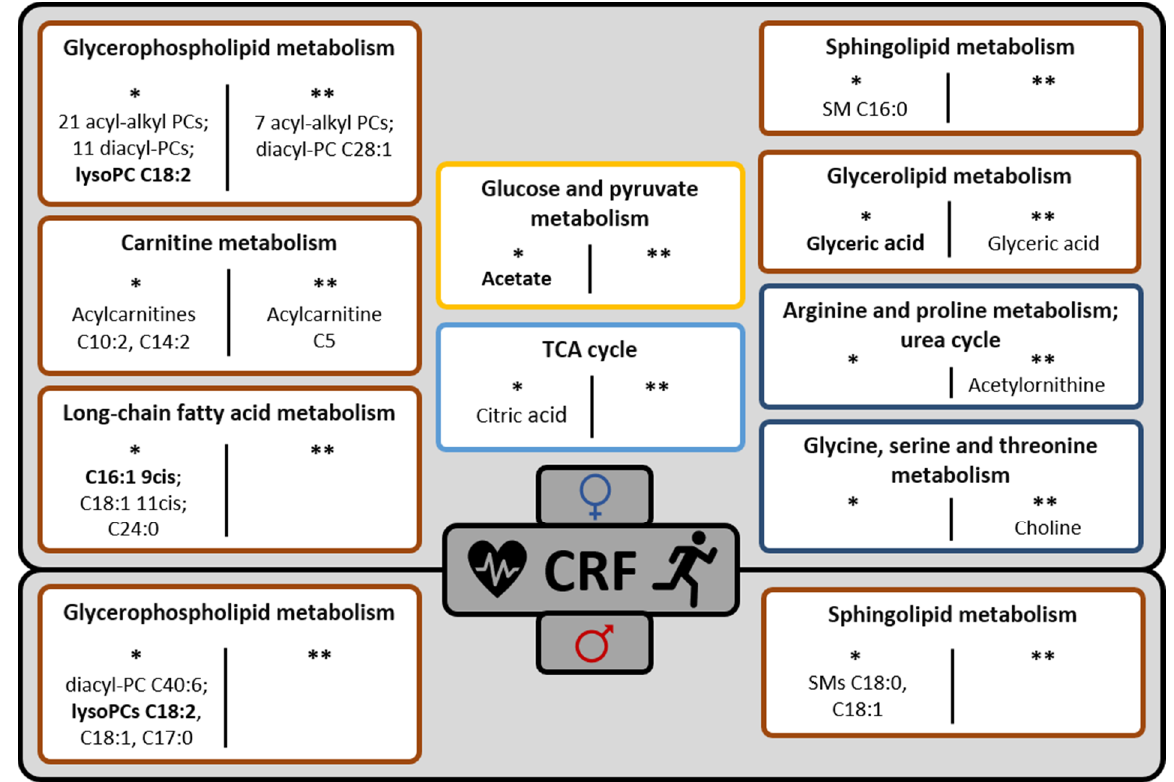
Figure 4. Classification of relevant CRF-associated plasma metabolites to major and specific metabolic pathways. Top: females; bottom: males. Major metabolic pathways are color-coded as follows: amino acid metabolism (dark blue); carbohydrate metabolism (yellow); energy metabolism (light blue); lipid metabolism (brown). * findings from confounder (age/menopausal status)-adjusted bi-/multivariate association analyses; ** findings from bivariate association analyses additionally adjusted for phenotypical/clinical variables. CRF: cardiorespiratory fitness; PC: phosphatidylcholine; SM: sphingomyelin. Metabolites with bivariate correlations to CRF that were significantly different from zero in both females and males are indicated in bold.